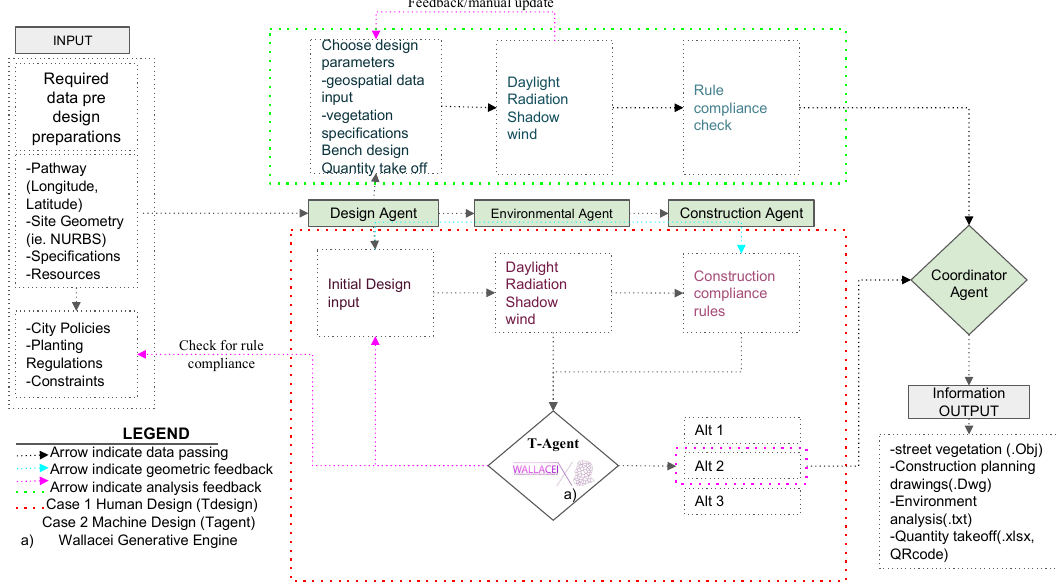
Figure 4. An illustration of the T-Agent design tool’s data process workflow and its comparison to T-Design decision-making process.